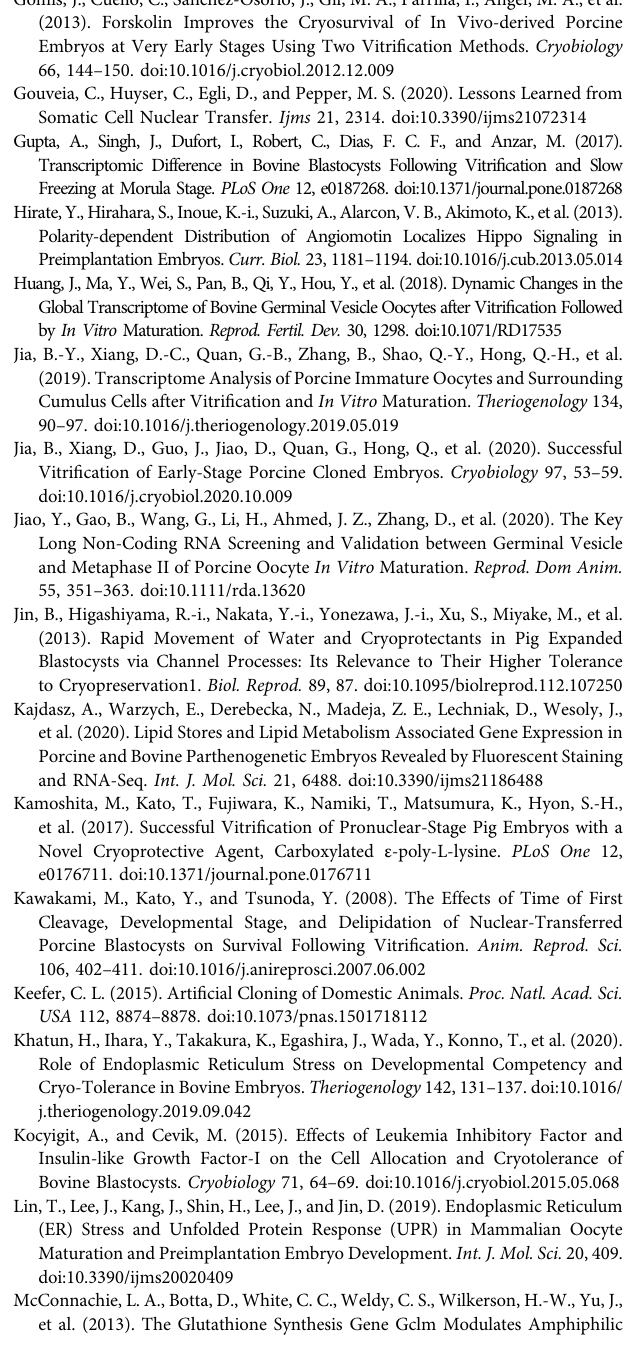
Supplementary Table S12 | GO and KEGG enrichment analysis of mRNAs in 4- cells. Supplementary Table S13 | GO and KEGG enrichment analysis of lncRNAs in 4- cells. Supplementary Table S14 | GO and KEGG enrichment analysis of mRNAs in blastocysts. Supplementary Table S15 | GO and KEGG enrichment analysis of lncRNAs in